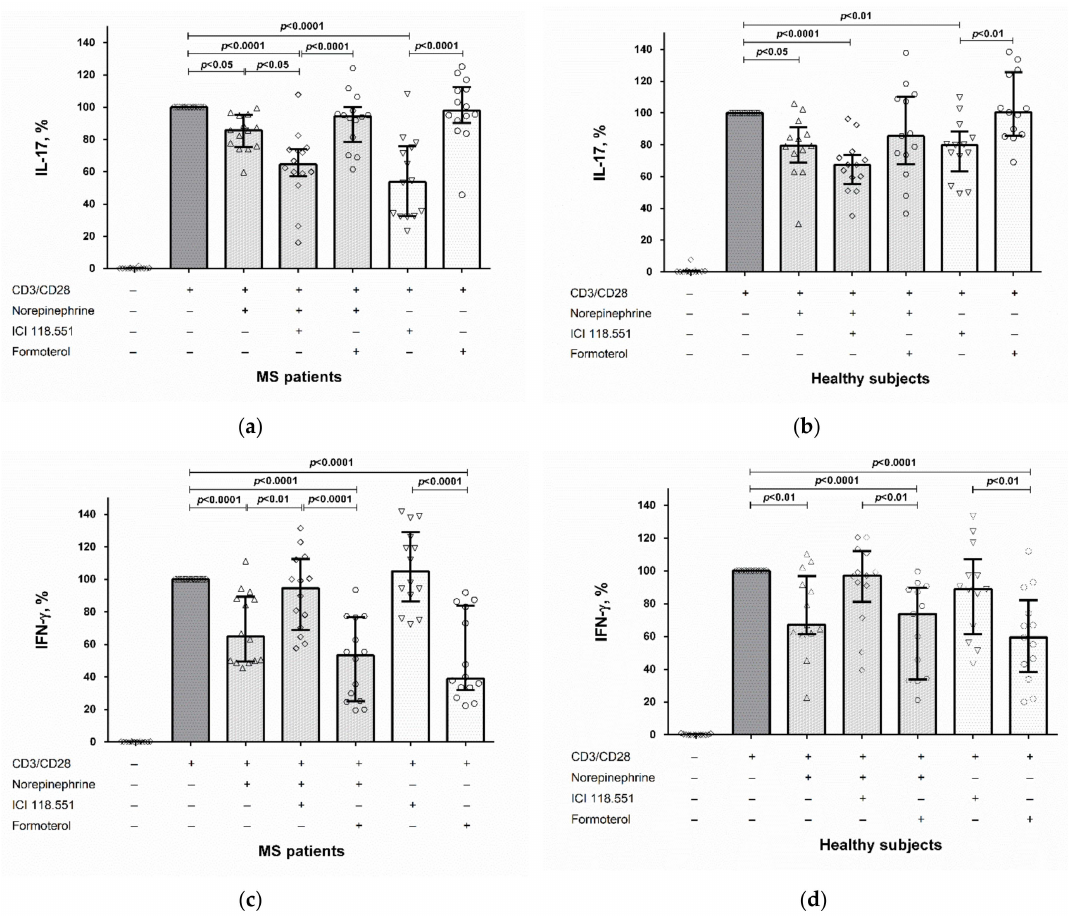
Figure 2. The role of the β 2 -adrenergic receptor in the norepinephrine-mediated suppression of IL-17 ( a , b ) and IFN- γ ( c , d ) production by stimulated CD4 + T cells in MS patients and healthy subjects. CD4 + T cells (8 × 10 4 per 200 µ L per well), obtained from MS patients or from healthy subjects, were pre-incubated with an antagonist or an agonist of the β 2 -adrenergic receptor (ICI 118.551 and formoterol, respectively) (at 10 − 6 M), whereafter norepinephrine (at 10 − 5 M) and anti-CD3/anti- CD28 microbeads or anti-CD3/anti-CD28 microbeads (without norepinephrine) were added to the cultures. After 72 h, the supernatants were collected and submitted to cytokine quantification by ELISA. Data are expressed as the percentage of cytokine production by stimulated cells in the absence of norepinephrine and β 2 -adrenergic receptor antagonist or agonist. The boxes in the graphs correspond to the medians and the whiskers indicate to 25th and 75th percentiles. The symbols in the graphs correspond to the data from each separately MS patient or healthy subject. The median values of the MS and control groups were compared, and the p values are indicated in the